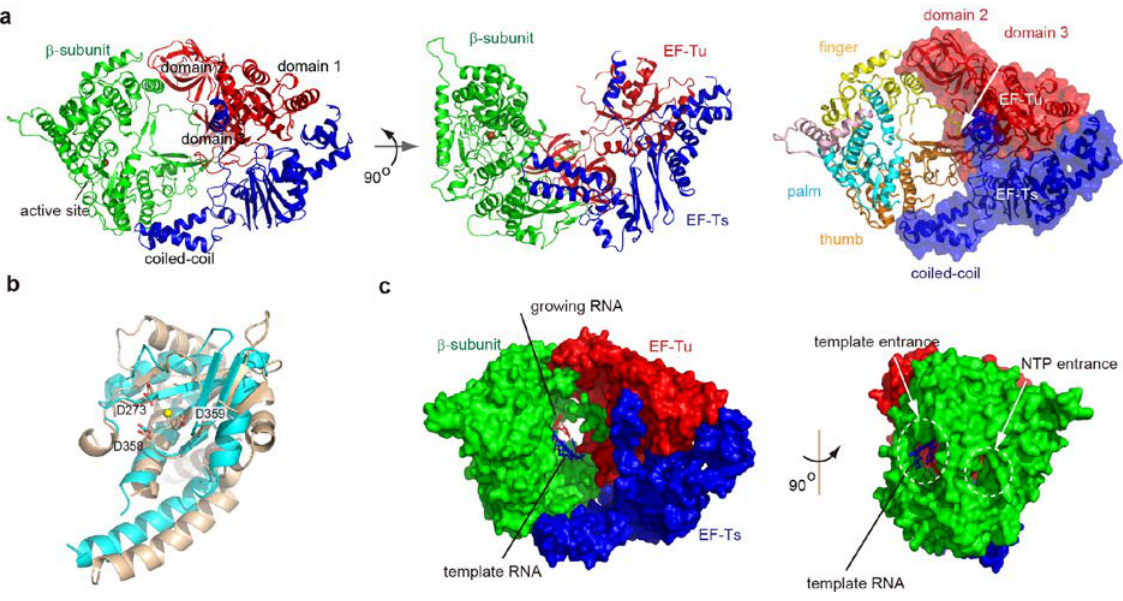
Figure 2. Structure of core Qβ replicase. ( a ) Overall structure of the core Qβ replicase. The β-subunit, EF-Tu and EF-Ts are colored green, red and blue, respectively ( left ). Interactions between subunits ( right ). The β-subunit consists of three domains, finger (yellow), palm (cyan) and thumb (orange); ( b ) Structures of the catalytic palm domains of the β-subunit (cyan) and phi-6 RdRp (brown). Catalytic carboxylates are depicted by stick models; ( c ) A model of RNA synthesis identified possible substrate tunnels in the core Qβ replicase. The double stranded RNA is shown, in which the template and growing RNAs are depicted by blue and red stick models,